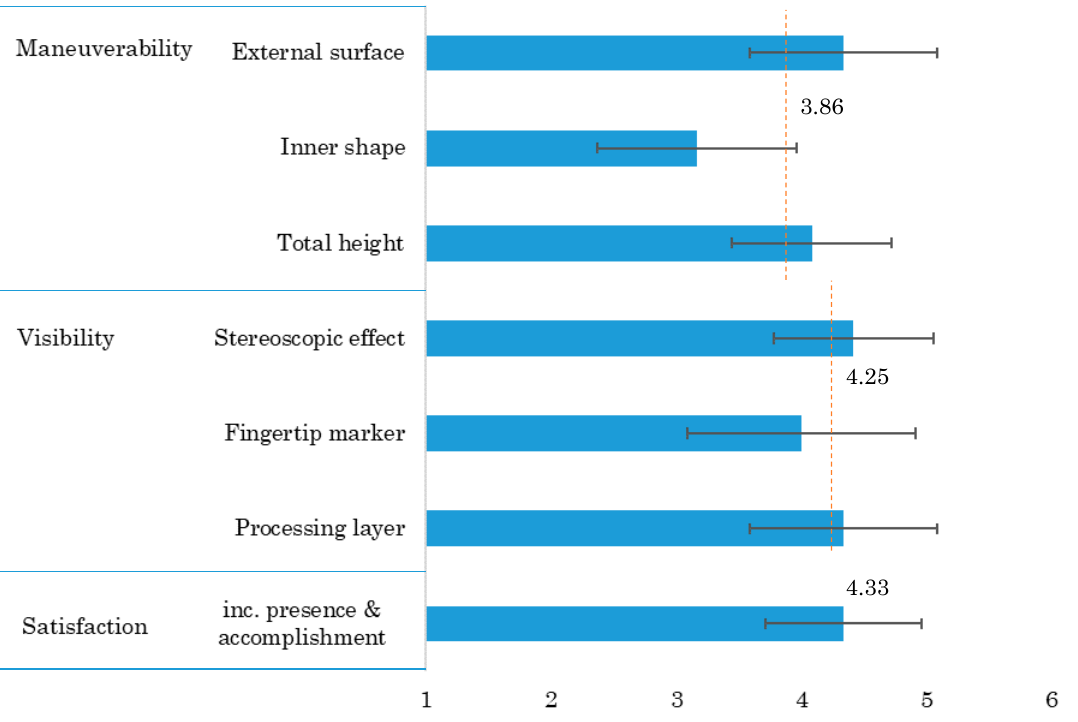
Figure 13. Result of questionnaire survey ( n = 12).